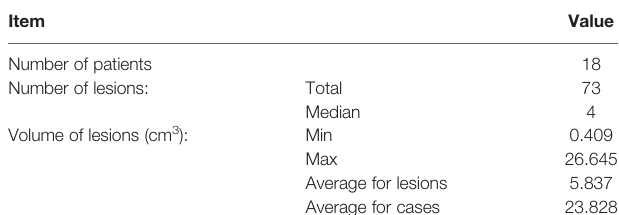
TABLE 1 | Detailed tumor